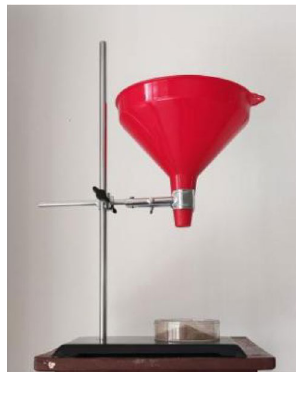
(a) Simulation experiment of Angle of repose (b) Angle of repose physics experiment Figure 4. Angle of repose